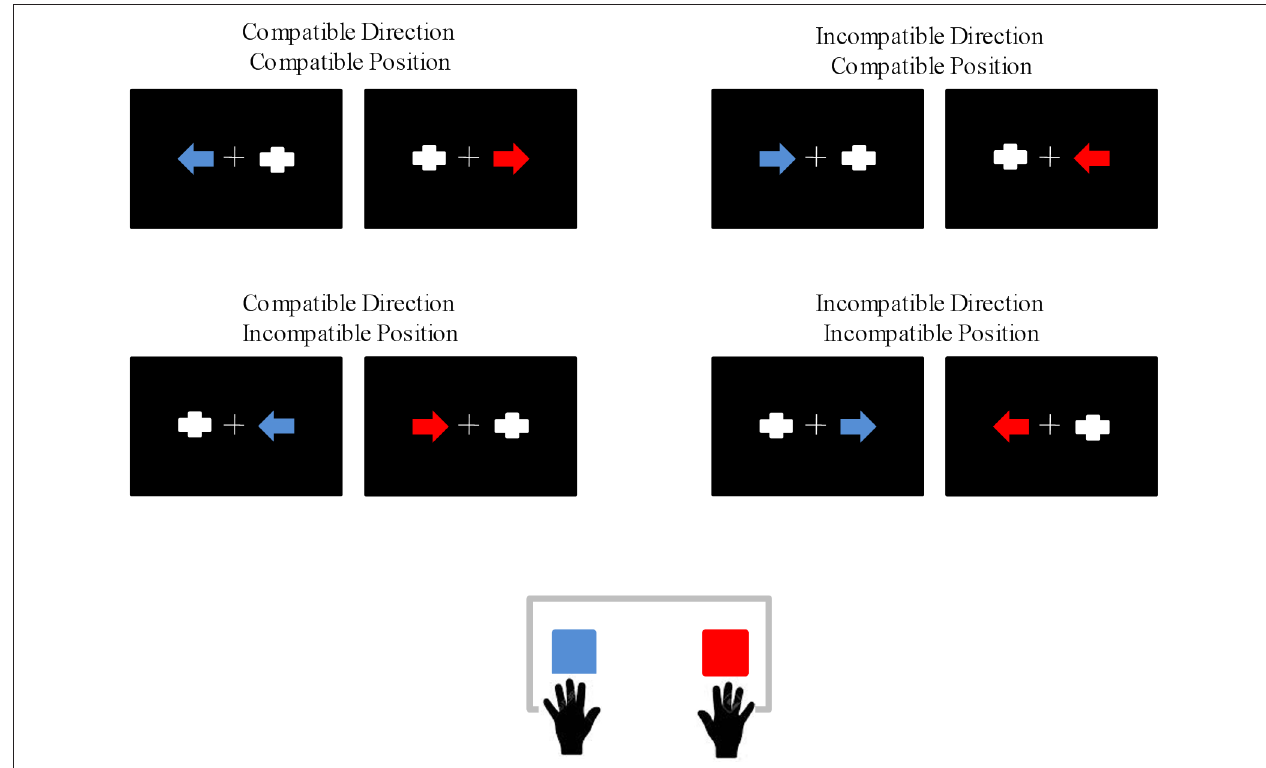
FIGURE 1 | Schematic representation of the eight types of stimuli, which gave rise to the following experimental conditions: Compatible Direction-Compatible Position (CDCP), In CDCP (IDCP), Compatible Direction-Incompatible Position (CDIP), InCDIP (IDIP). Eighty trials per experimental condition were presented, giving rise to 320 trials in total. The response buttons assigned to each color were counterbalanced among participants.